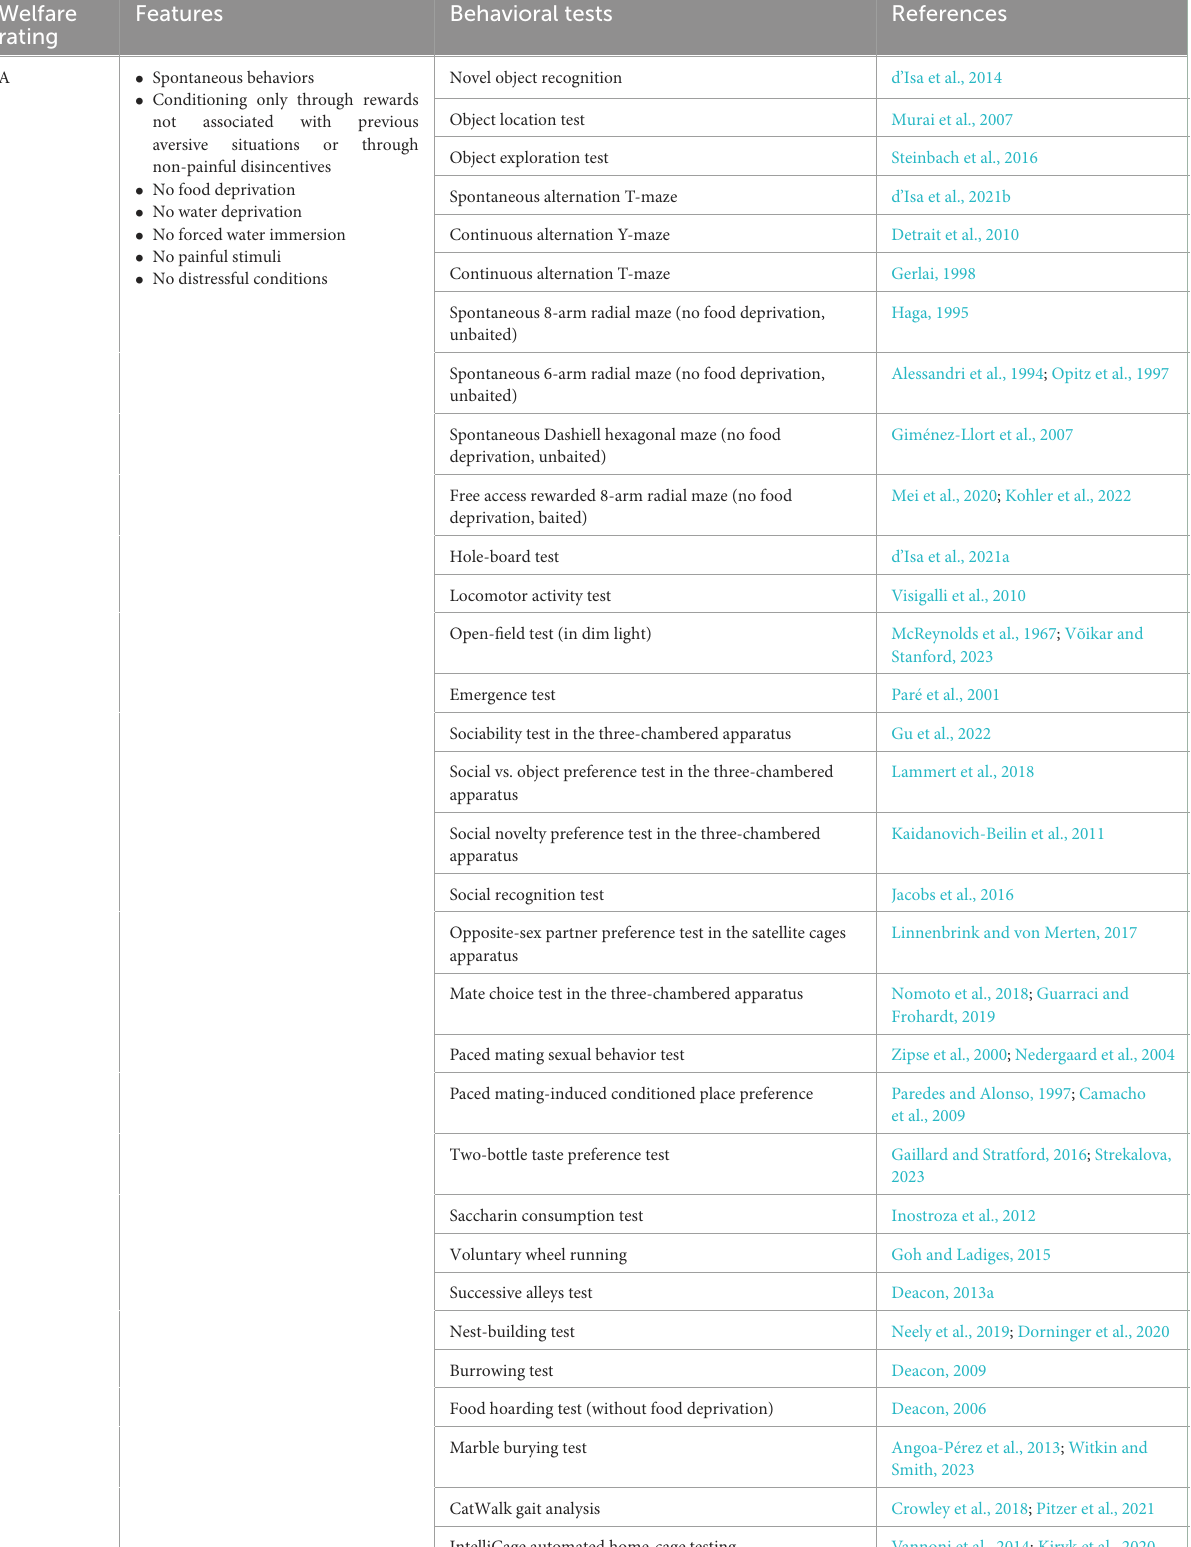
TABLE 1 Rating of the impact of behavioral tests on animal